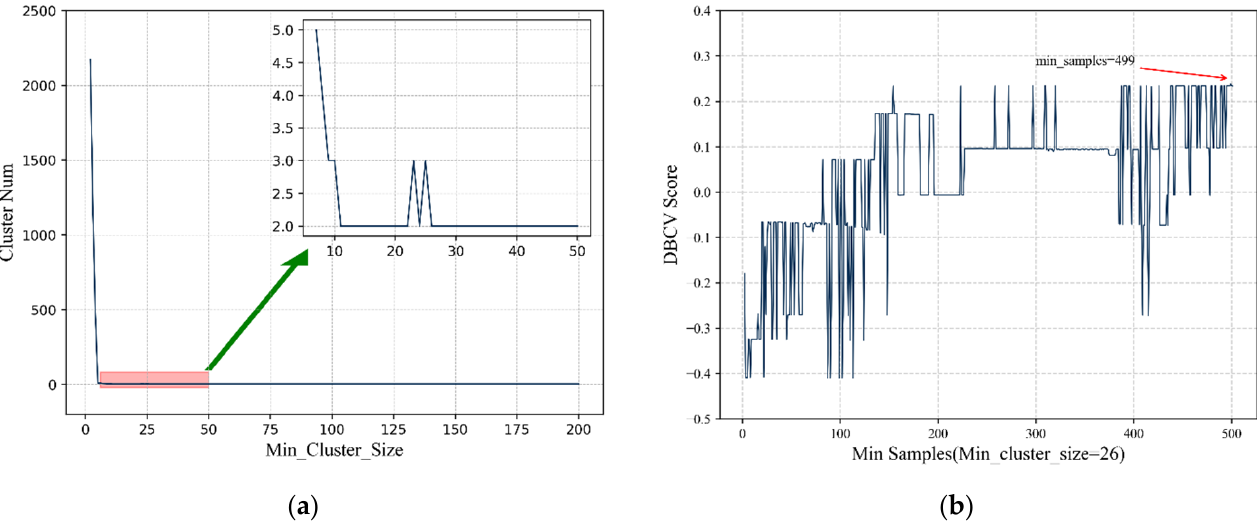
Figure 9. The optimization process and results for parameters of HDBSCAN. As illustrated ( a ) is the optimization result of min_cluster_size while ( b ) shows the optimization result of min_samples .